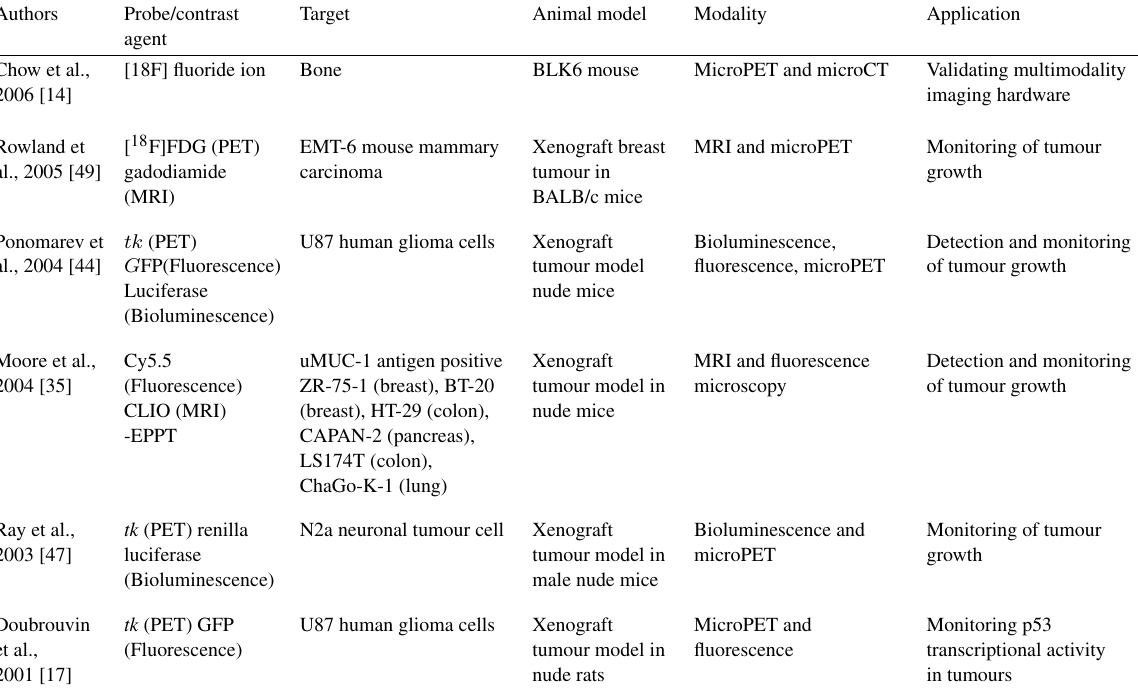
Summary of the different imaging modalities and its